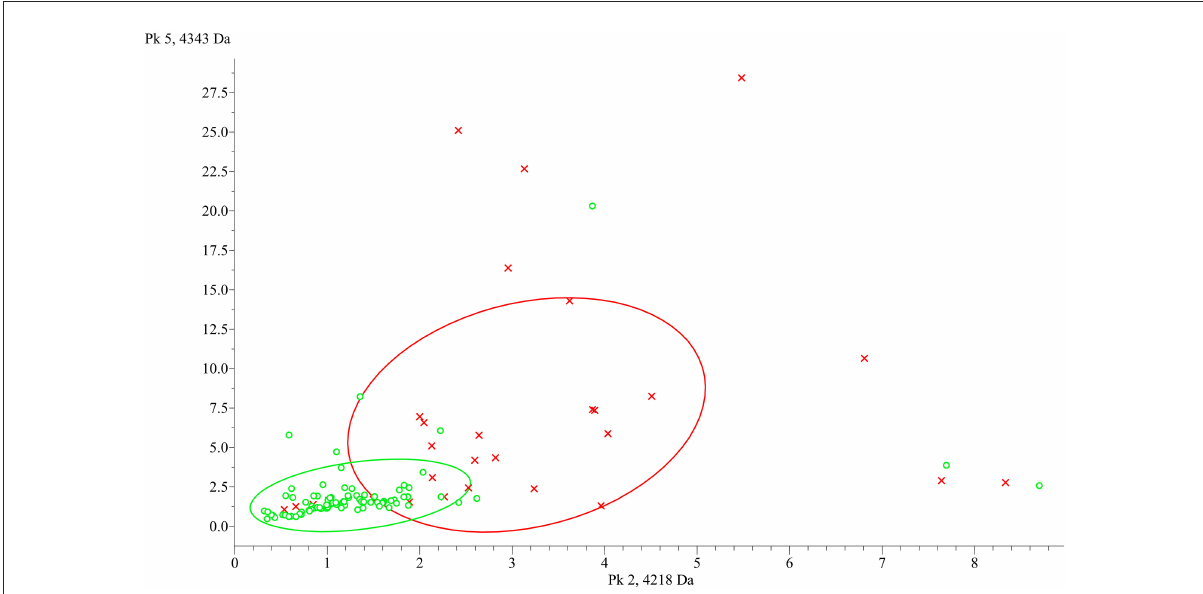
FIGURE3 ClinProTools 2D distribution of the two most discriminant peaks between group L (green) and H (red). x-axis: 4,218.2 m/z, y-axis: 4,342.98 m/z.